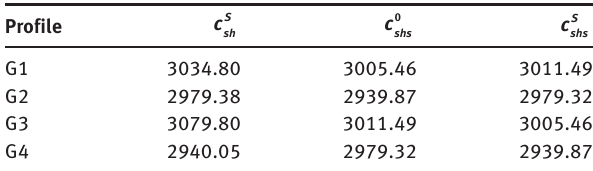
Table 8: Bulk shear wave velocity associated with a homogeneous half-space made of material with properties attained by the FGMEE over-layer at the layer-substrate